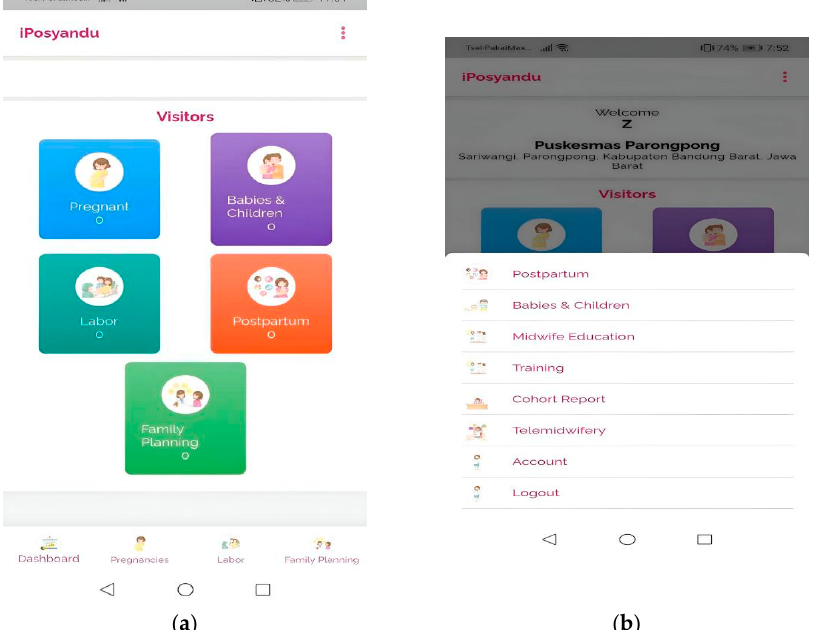
Figure 2. Initiation of mHealth for Midwives: ( a ) Health services menu display; ( b ) Learning menu.